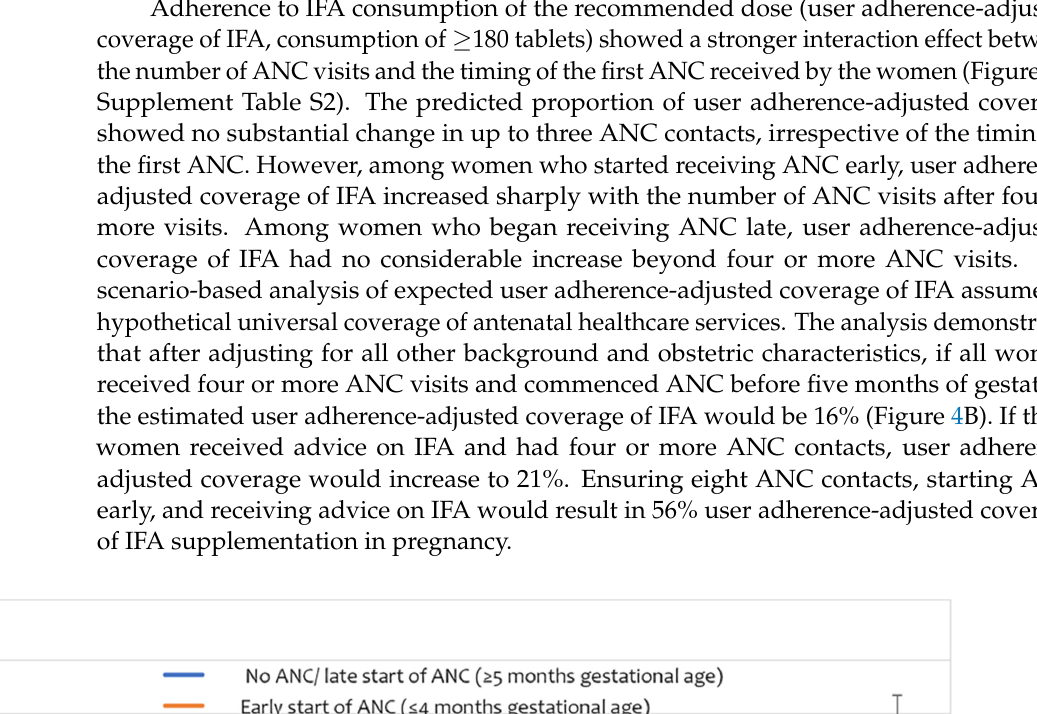
Figure 4. ( A ) User adherence-adjusted effective coverage of IFA supplementation (consuming ≥ 180 IFA) by the number of ANC and timing of first ANC, ( B ) scenario-based projections of user adher- ence-adjusted coverage of IFA assuming universal coverage of relevant antenatal interventions. * Adjusted for region/area, mother’s education, wealth, exposure to mass media, birth order, receiv- ing free IFA, and receiving IFA only from ANC contracts. IFA—iron and folic acid, ANC—antenatal care. 4. Discussion Adherence to antenatal IFA supplementation is low in Bangladesh [29]. Our study reports the critical predisposing, enabling, and need factors of Andersen’s Behavioral Model of healthcare utilisation that influence receiving and consuming antenatal IFA. We uniquely report the difference in the quantity of IFA supplements received and consumed during pregnancy. The user adherence-adjusted coverage of antenatal IFA supplementa- tion is positively associated with the number of ANC visits, early start of ANC, and re- ceiving advice on IFA. Our modified falter point analysis of IFA coverage fills the data gap on the consumption of adequate ≥ 180 IFA supplements in the previous analysis [46].